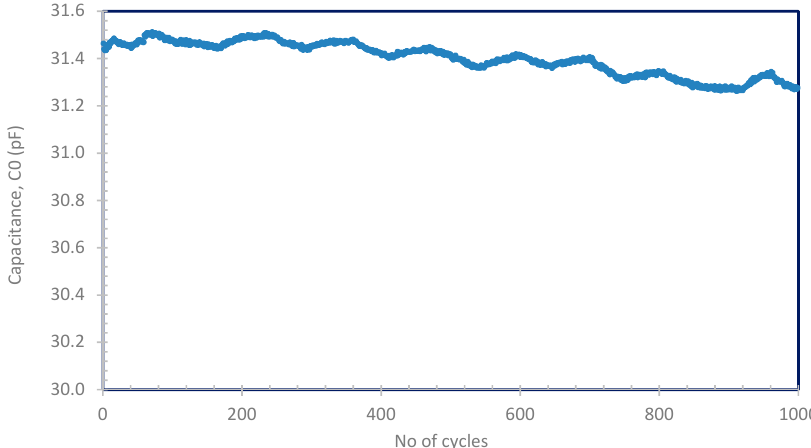
Figure 10. The zero-strain capacitance of the stretch sensor with 40 wt% BTO with respect to stretch/relax cycles.